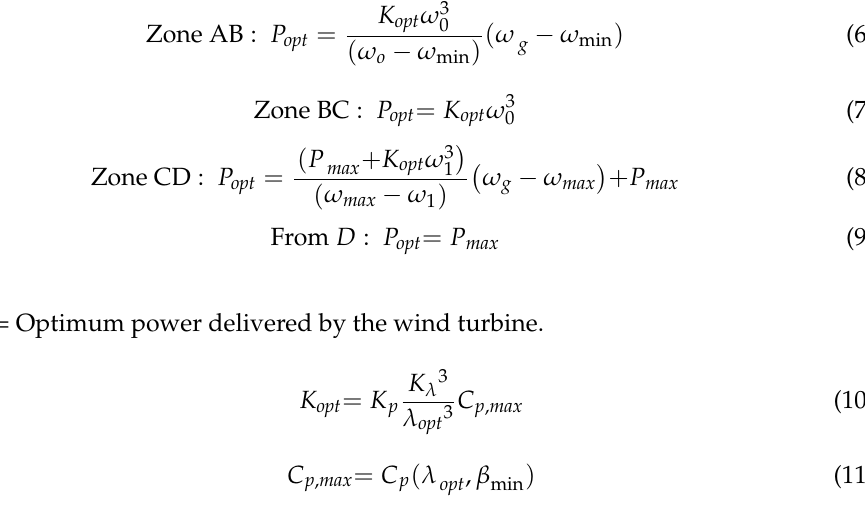
Figure 6. Maximum power point tracking curve for the wind turbine model MADE AE-59.